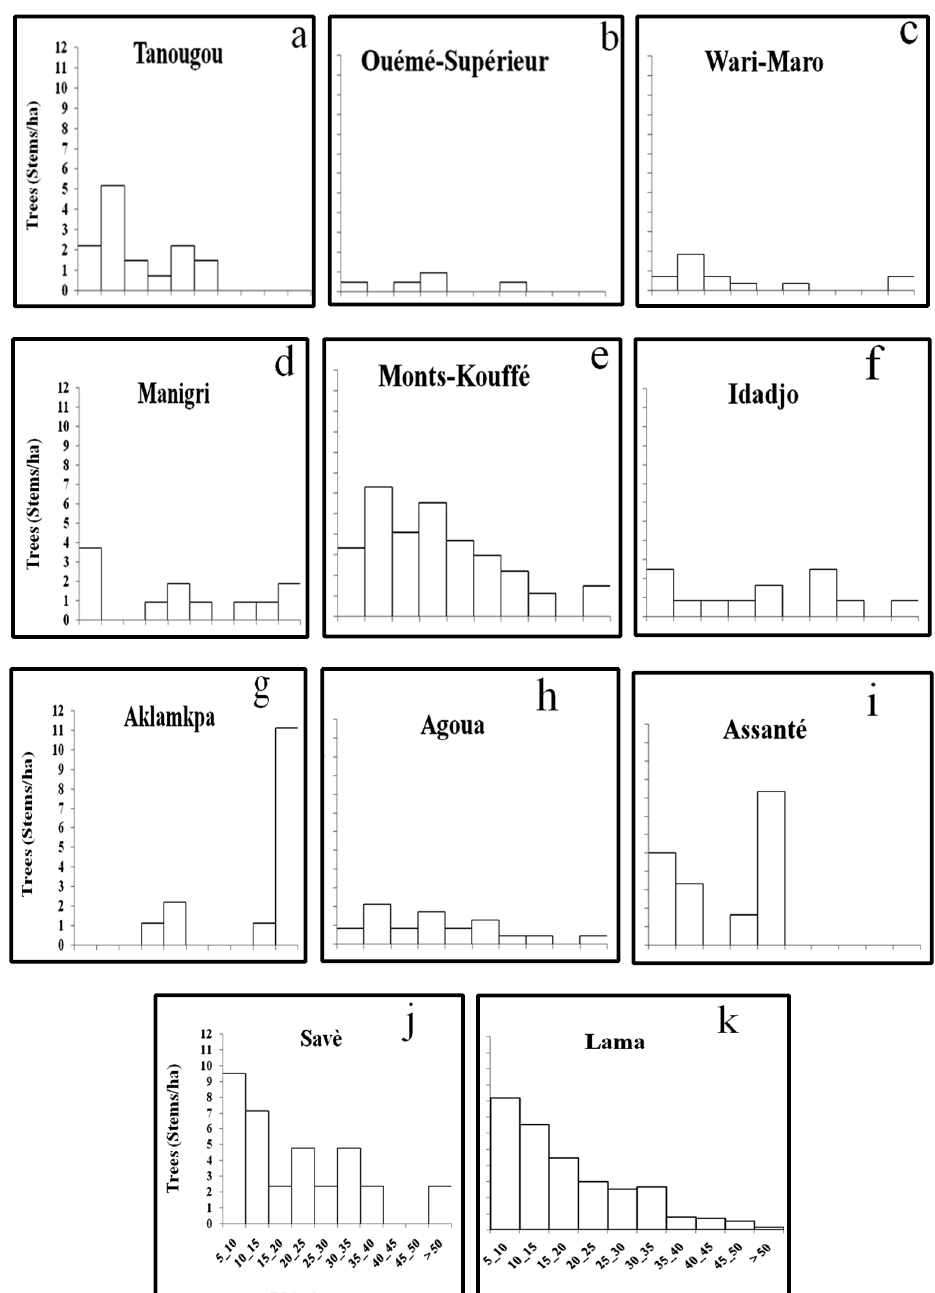
Figure 3. Size class distribution for M . kummel ( a – j ) and M . andongensis ( k ) in the study forests. The Permutation index calculated for the different forests was greater than zero (Table 7). However, the index value was very low in Lama Forest reserve (P = 2), showing a more monotonically declining reverse-J structure than in the other forests. Based on the Simpson index, size classes were more evenly distributed in Idadjo, Sav è , Agoua and Ou é m é Sup é rieur (C = 0.1), while, in the other forests, SCDs were steeper than would be expected from an exponentially declining population (C > 0.1). The quotients obtained between numbers of trees in successive size classes fluctuated widely, potentially indicating unstable populations of Mimusops species; but the fluctuation was less pronounced in Lama Forest reserve (Figure